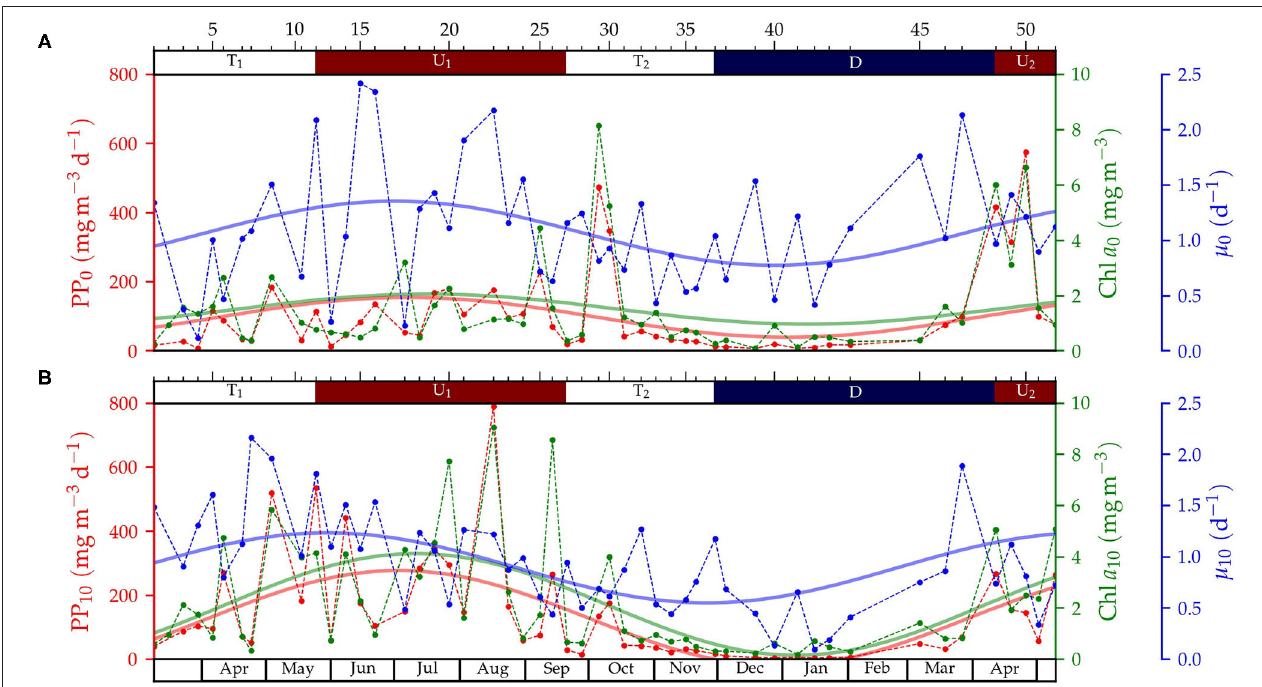
FIGURE 4 | Time-series of primary production rates (PP, red), chlorophyll a (Chl a , green) and growth rates ( µ , blue) at (A) surface ( z ∼ 0m) and (B) 10 m depth. Data for each sampling are represented by circles connected by a dashed line, and the seasonal mode (computed by fitting to a sinusoidal curve), with solid line. The ticks and numbers on the top axis indicate the sampling number and the colors, the periods for upwelling (U 1 and U 2 , in red), downwelling (D, in blue), and transition (T 1 and T 2 , in white).